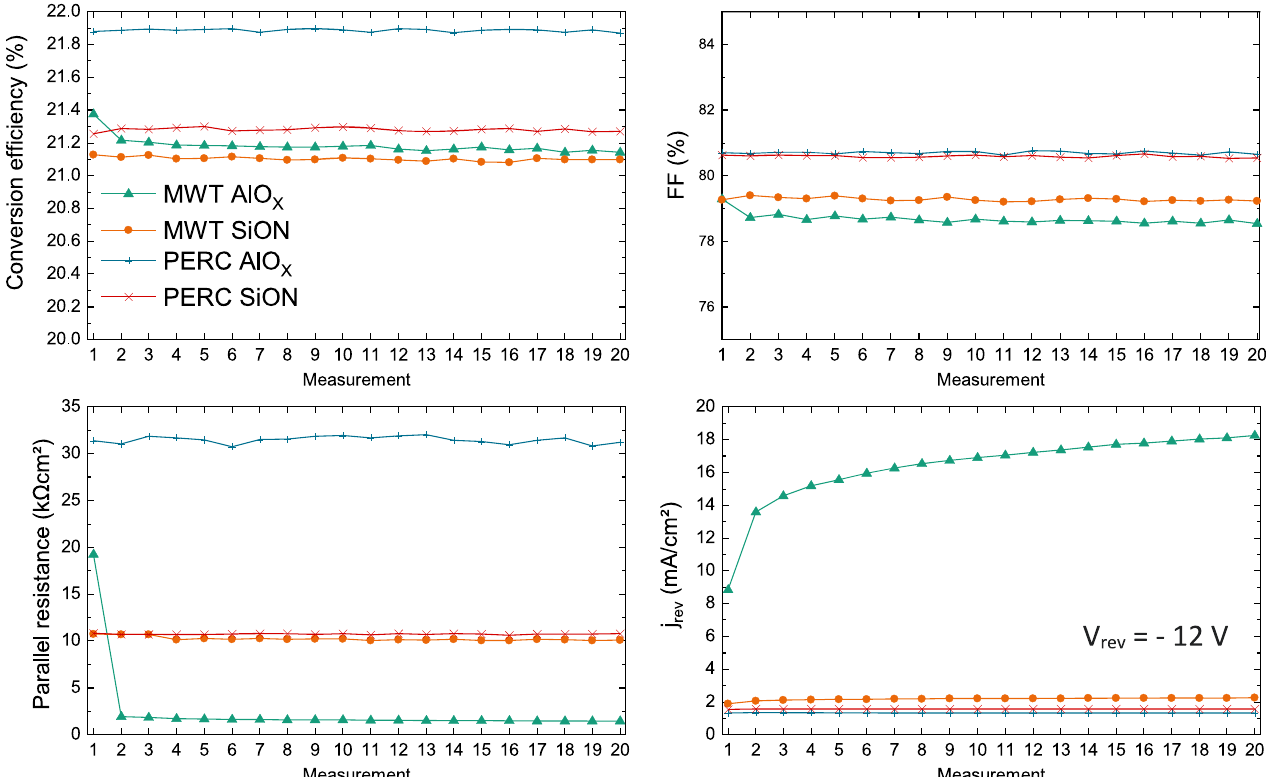
Fig. 8. Cell parameter shift over 20 consecutive reverse bias cycles. With the ef fi ciency h , the fi ll factor FF, the parallel resistance R p and the reverse current-density j rev at a reverse bias of V rev =-12V. The HIP-MWT+ cell that uses the AlO X is signi fi cantly affected by the reverse bias. The increase in reverse current – density goes hand in hand with the deterioration of R p which has the negative impact on the